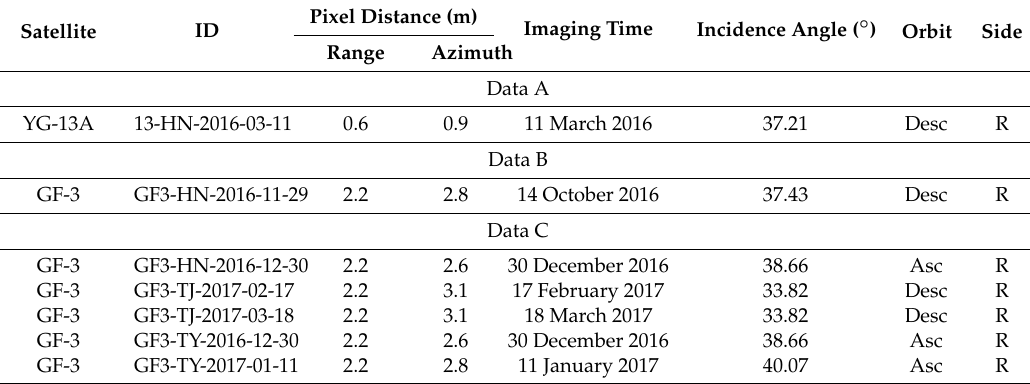
Table 1. Experimental image specifications for validation of the proposed